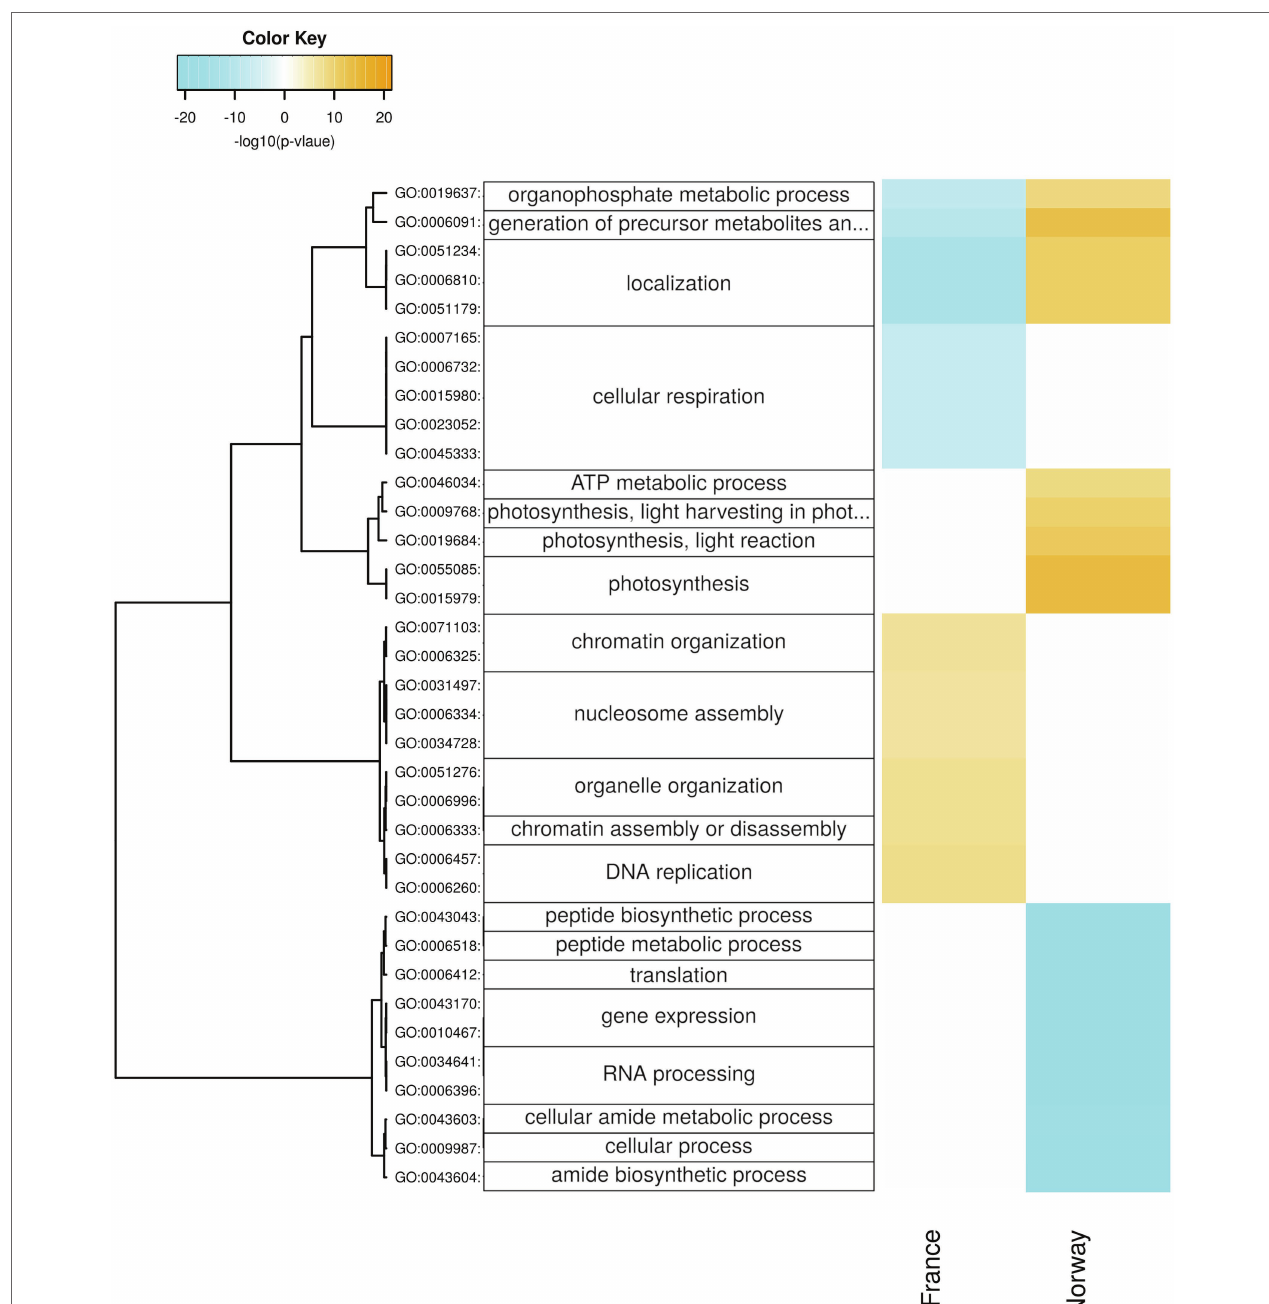
FIGURE 6 | Seasonal changes in biological processes. Enriched processes are shown for each population with positive-log10 ( p ) for genes upregulated in summer (orange) and with negative-log10 ( p ) for genes upregulated in winter (cyan). The hierarchical cluster of GO terms is based on Euclidean distance and a ward.D2 clustering algorithm (Ward’s minimum variance